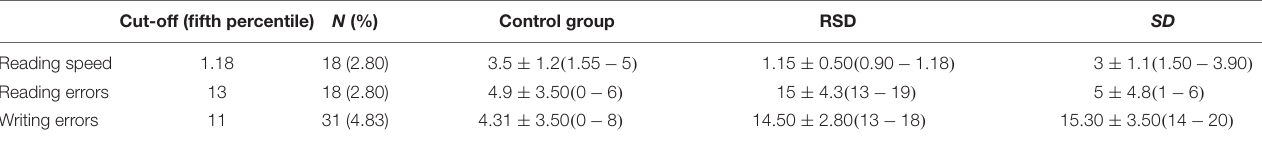
TABLE 1 | Cut-off scores, number and proportion of children falling below the cut-offs, reading speed (syllable/seconds), reading accuracy (number of errors), and writing accuracy (number of errors) of control group, RSD, and SD children in third grade (mean, standard deviations, and range). Cut-off (fifth percentile) N